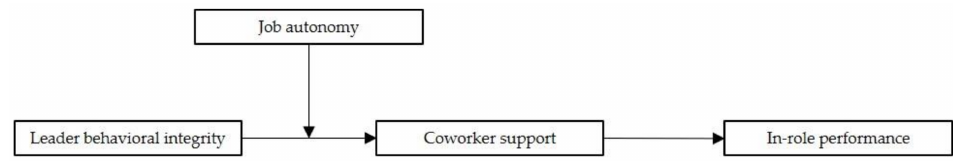
Figure 1. Conceptual